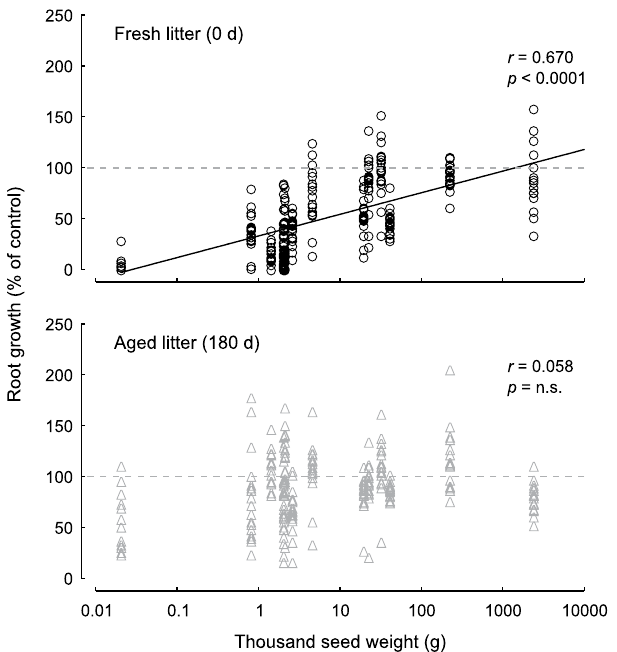
compounds 17 . The nutrient immobilization hypothesis sustains that litter with high C/N ratio, by reducing nitro- gen relative availability, would limit root system development. However, such hypothesis is not supported by the present work, because litter N content and C/N ratio in our bioassays was unrelated to root proliferation for all target plant species. This indirectly suggests that other causal factors should be taken into account to explain the